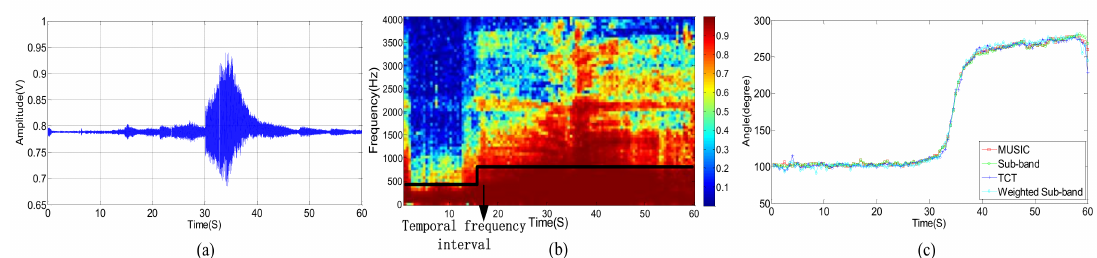
Figure 11. ( a ) Acoustic signal of a vehicle passing the microphone array approximate no wind. ( b ) The sub-band correlation of ( a ). ( c ) Vehicle tracking approximate no wind.